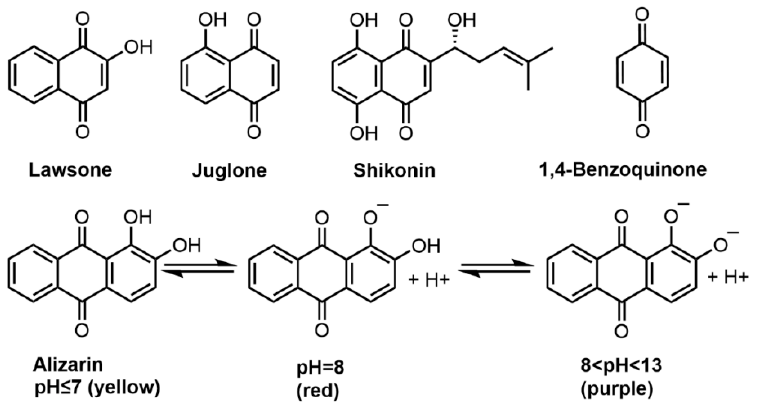
Figure 2. Molecular structures of lawsone, juglone, shikonin, 1,4-benzoquinone, alizarin and the color changes at acid–base conditions.